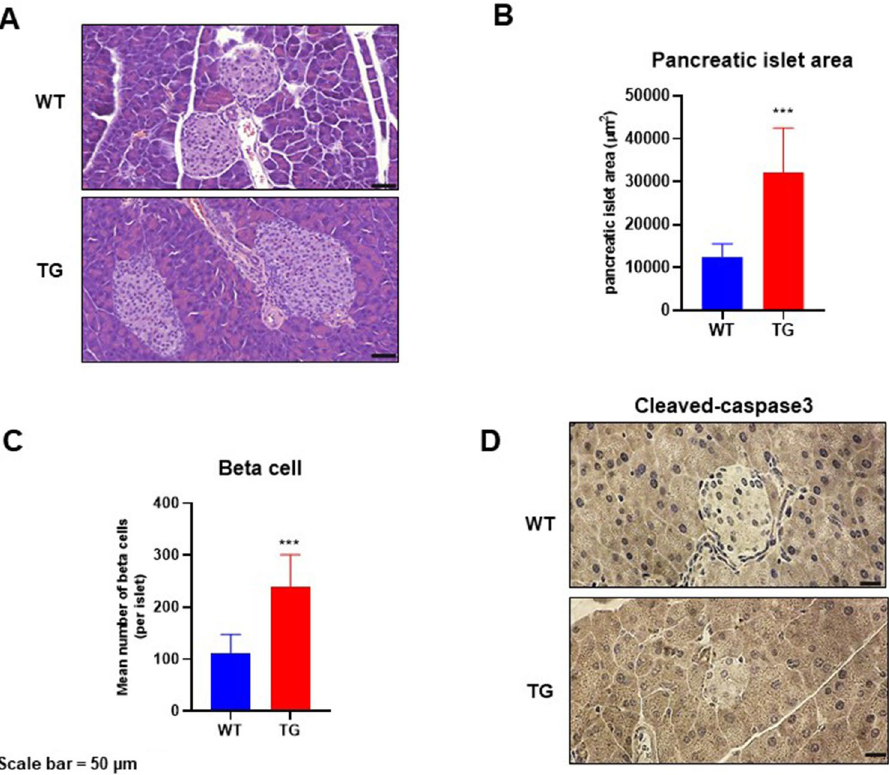
Figure 5. Pancreatic islet architecture. The pancreatic sections were prepared and stained with hematoxylin and eosin (H&E) or anti-cleaved caspase-3 antibody. ( A ) Representative images of H&E-stained pancreatic sections from different groups. Scale bar = 50 µm. ( B , C ) Pancreatic islet area and beta cell number were measured as described in the methods section. Data are shown as mean ± standard error of mean. ***p < 0.01. ( D ) Immunohistochemical analysis of cleaved caspase-3 in the pancreas islets. Scale bar = 50